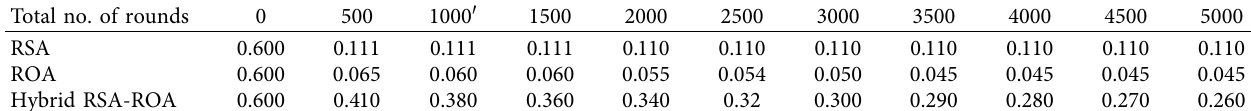
Table 8: Average remaining energy over different number of rounds for network 1.